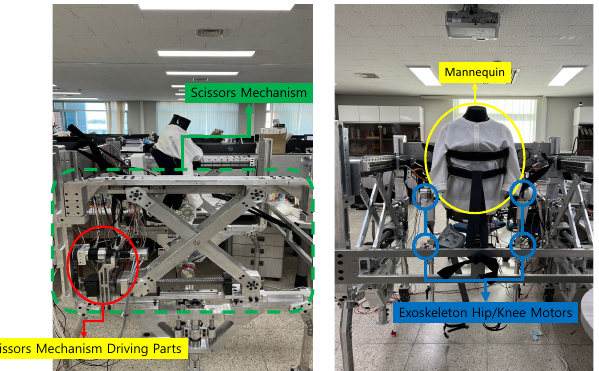
Figure 14. Experiment setup. The left figure shows the side of the pelvic support robot. The green dotted line indicates all the scissor mechanism parts. The red circle indicates the scissor mechanism driving parts. This motor facilitates the pelvic obliquity motion. The right figure shows the front side of pelvic support robot with the exoskeleton robot. We use the mannequin as a human dummy (indicated by the yellow circle). The four blue circles indicate the exoskeleton robot motors. These motors facilitate the hip/knee flexion and extension motion.